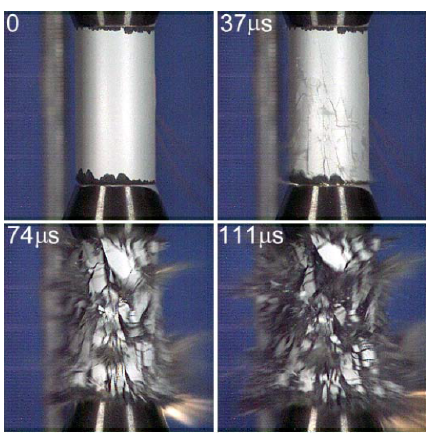
Figure 3. Explosive failure of the SiC-N specimen (12.7mm in diameter and 25.4mm in length) subjected to unconfined uniaxial compression ( σ 1 = 3988MPa at failure) (Lee et al., 2005).